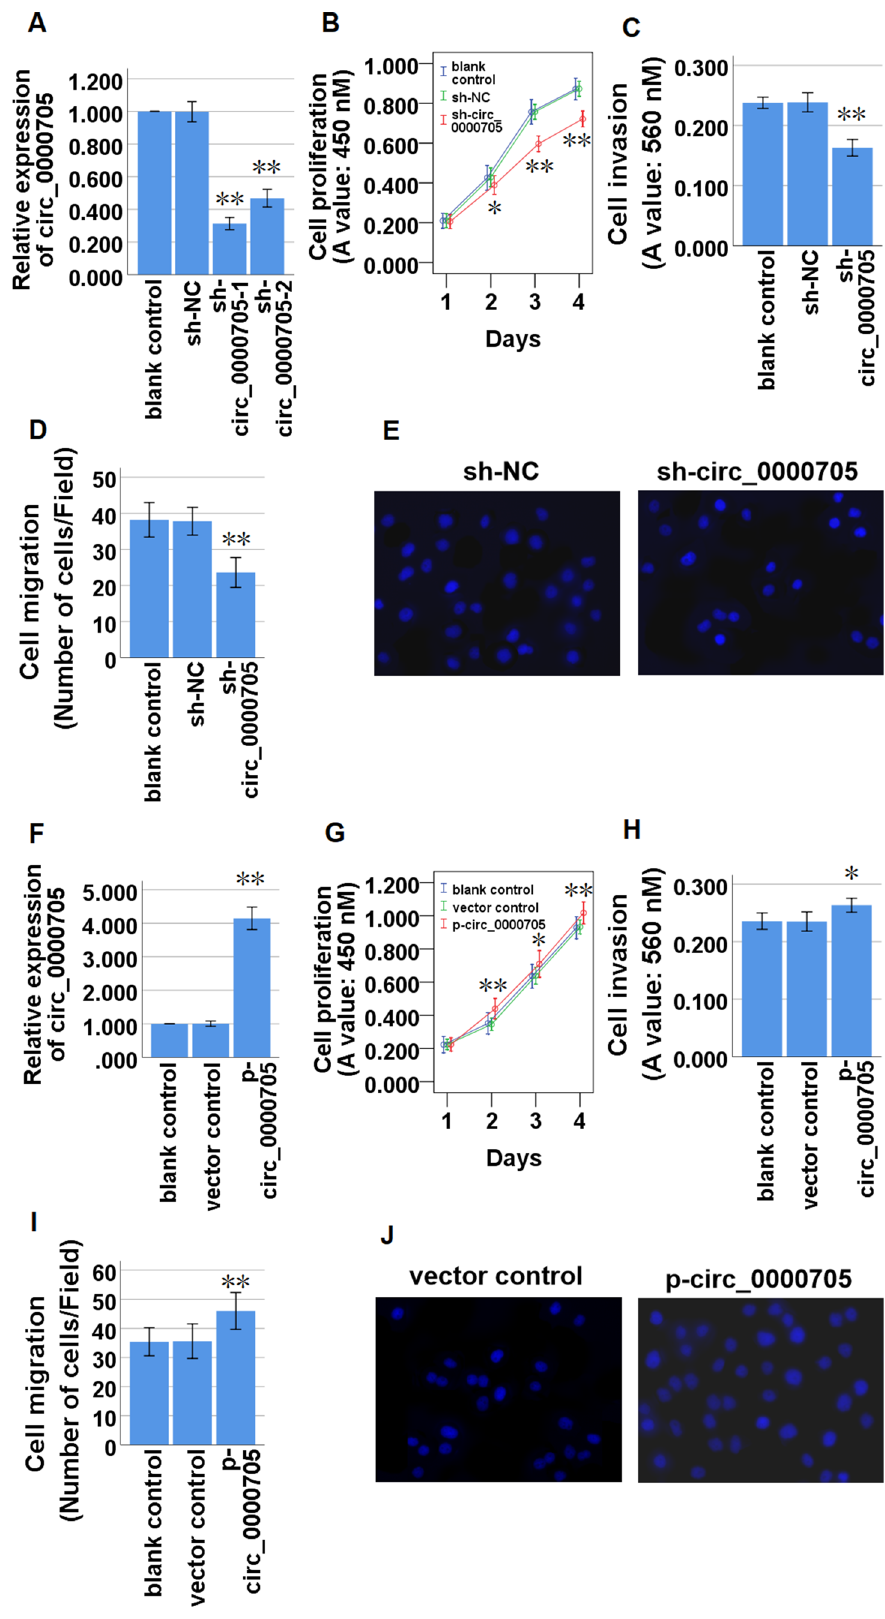
Fig. 2 Effects of circ_0000705 on the cell proliferation, inva- sion and migration of ESCC cells. A The expression of circ_0000705 was down-reg- ulated in KYSE150 cells trans- fected with sh-circ_0000705. B Effect of circ_0000705 knockdown on the cell proliferation of KYSE150 cells detected by the CCK-8 assay. C Transwell assay with Matrigel was performed to detect the cell invasion in KYSE150 cells with circ_0000705 knock- down. D Transwell assay with- out Matrigel was performed to detect the cell migra- tion in KYSE150 cells with circ_0000705 knockdown. E Representative photos of the cell migration in KYSE150 cells were manifested (original magnification, × 200). F The expression of circ_0000705 was up-modulated in KYSE30 cells transfected with p-circ_0000705. G Effect of circ_0000705 over-expression on the cell proliferation of KYSE30 cells detected by the CCK-8 assay. H Tran- swell assay with Matrigel was used to detect the cell invasion in KYSE30 cells with circ_0000705 over-expression. I Transwell assay without Matrigel was used to detect the cell migration in KYSE30 cells with circ_0000705 over- expression. J Representative photos of the cell migration in KYSE30 cells were manifested (original magnification, × 200). * P < 0.05, and ** P < 0.01 vs